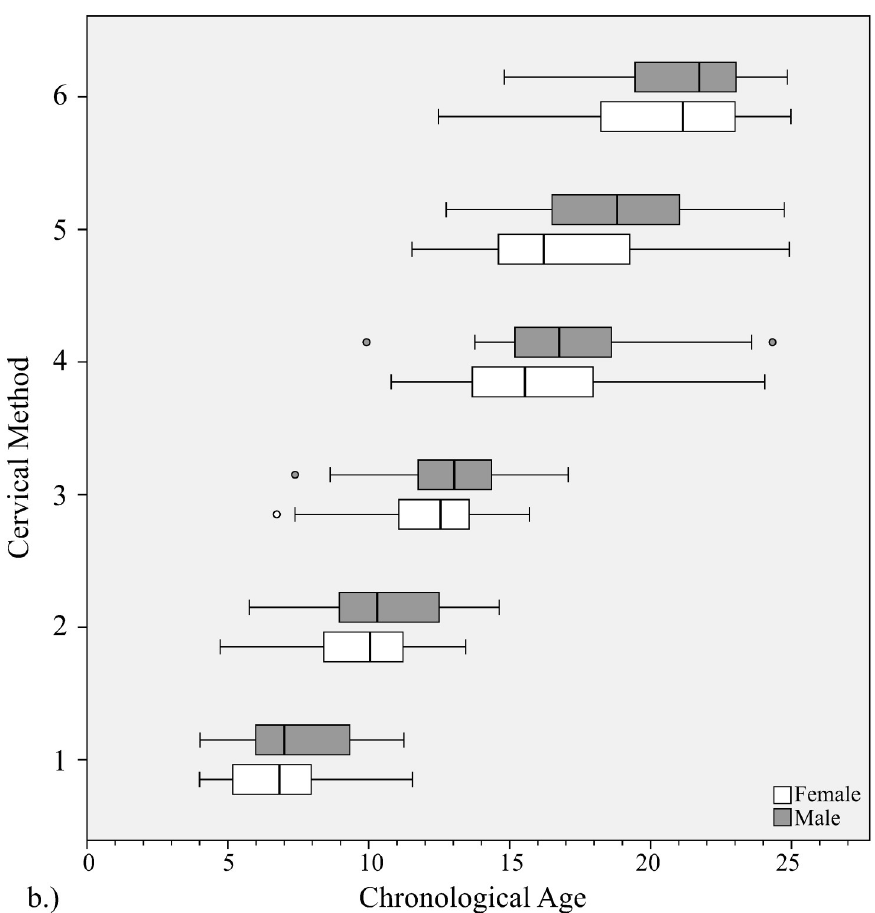
Fig 4. Distribution of chronological ages at each bone age stage with cervical method. Gender is shown at each stage.